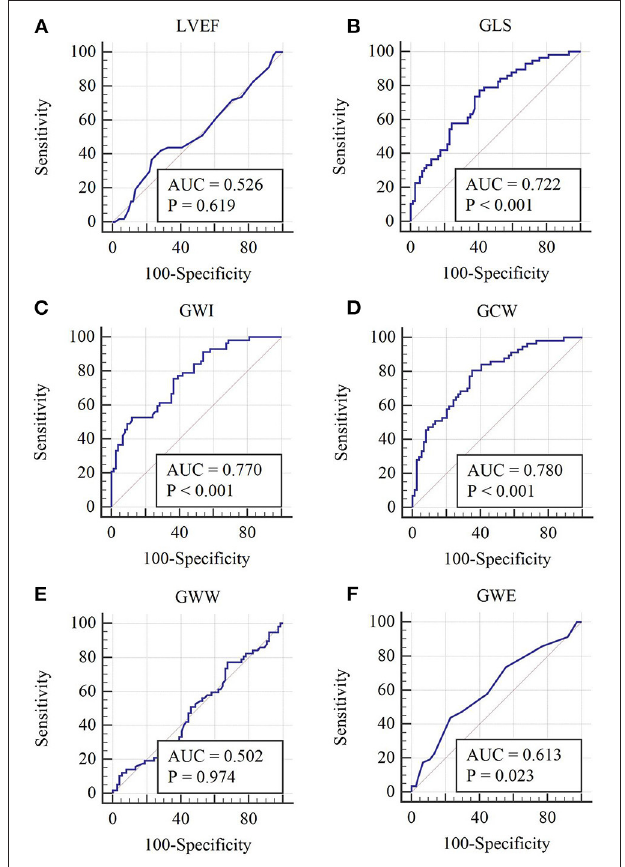
FIGURE 2 | Receiver operating characteristic curves of each global MW parameter. (A–F) Receiver operating characteristic curves of LVEF, GLS, GWI, GCW, GWW, and GWE,